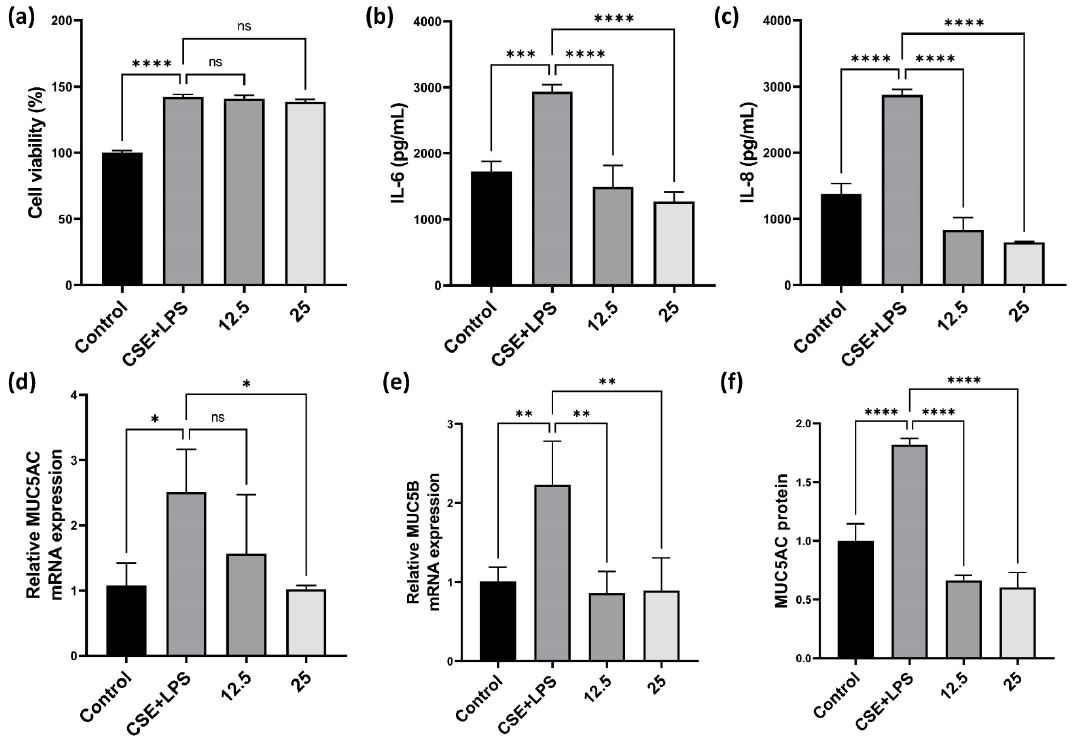
Figure 3. Effect of the CLE on cell viability, the production of cytokines and mucins in H292. ( a ) H292 cells were co-treated with 12.5, 25 µ g/mL of CLE and 2% CSE and 20 ng/mL LPS for 24 h. Cell viability was estimated by the WST assay. ( b , c ) H292 supernatants were analyzed for IL-6 and IL-8 by ELISA. ( d , e ) Total RNA samples were analyzed for MUC5AC and MUC5B mRNA expression by qRT-PCR. ( f ) MUC5AC proteins analyzed by ELISA assay. Data were analyzed by one-way ANOVA by Dunnett’s test. All values are reported as mean SD. * p < 0.05, ** p < 0.01, *** p < 0.001, **** p < 0.0001. CLE: Camellia sinensis L. extract, CSE: Cigarette smoke extract, LPS: Lipopolysaccha- ride, IL-6: Interleukin 6, IL-8: Interleukin 8.